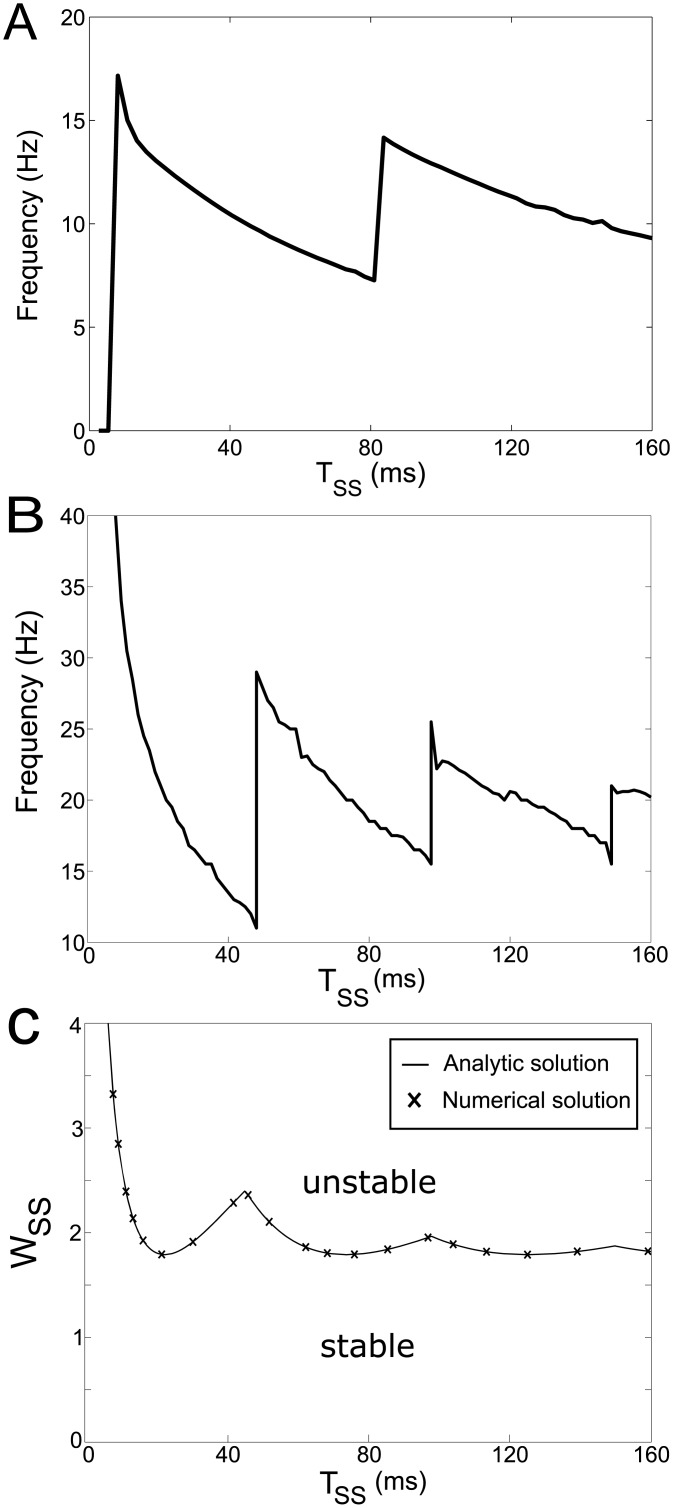
Effects of time delay in cortical feedback on model behaviour.A) The dependence of frequency in the feedback model on the delay in the long loop. B) The frequency range of oscillations produced by the linear system with delay only in cortical feedback for parameters that correspond to those along the stability boundary in panel C (i.e. for w
SS slightly higher than the one at the stability boundary for a given T
SS). C) The stability boundary of the linear system with delay only in cortical feedback. The analytic solution (solid curve) is overlaid with the numerical solutions (crosses). When the system is in the parameter region above the stability boundary the STN-GPe circuit oscillates.